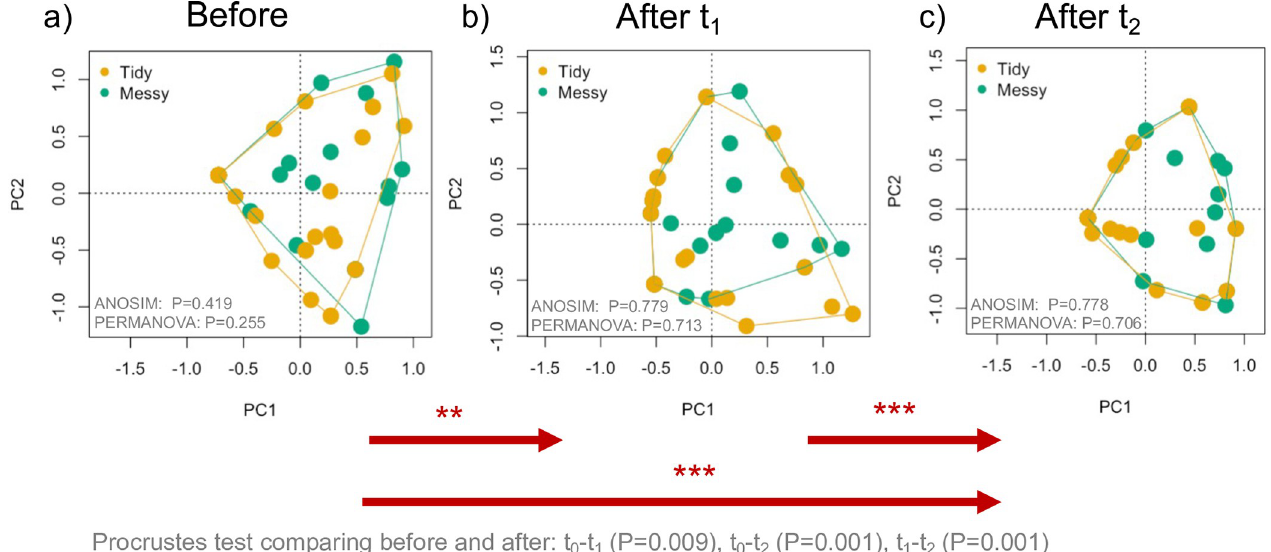
Fig 3. Changes in arthropod natural enemy community composition through the duration of the experiment at the order taxonomic level. Each point on the plot represents the composition of individuals within orders found within pitfall traps and visual observations within a garden bed, within a given treatment (tidy, messy). Singleton species were removed from this analysis. Significant differences in community composition between treatments were tested with ANOSIM and PERMANOVA, and differences between the time points (t 0 and t 1 , t 1 and t 2 , t 0 and t 2 ) were tested using Procrustes tests. Arrows and asterisk indicate significant differences between natural enemy communities within garden beds between time points for the Procrustes tests (Significance: ‘ � ’ 0.05, ‘ �� ’ 0.01, ‘ ��� ’ 0.001).